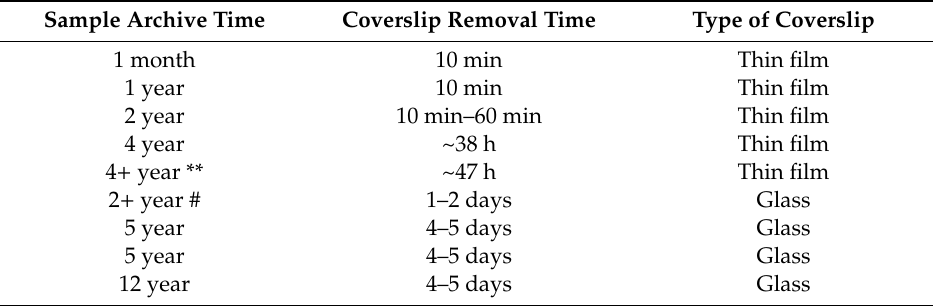
Table 2. Time tracking and coverslip parameters.